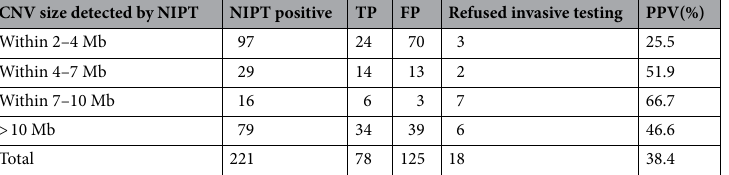
Table 5. The PPVs for all fetal CNVs indicated by NIPT-Plus according to different CNV sizes. TP true positive, FP false positive, PPV positive predictive value.